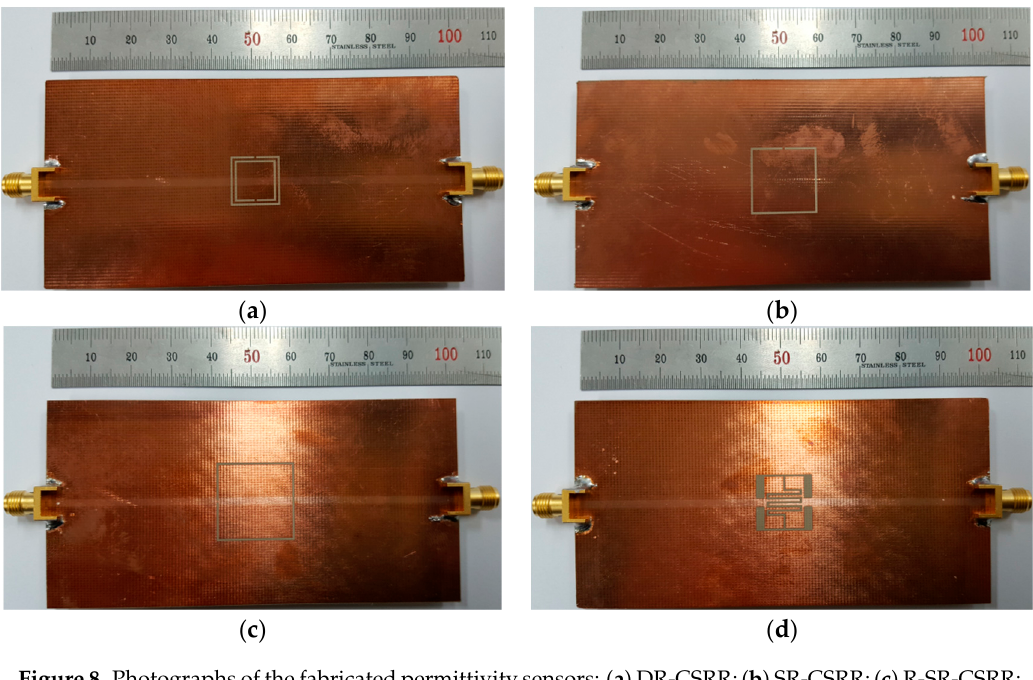
Figure 8. Photographs of the fabricated permittivity sensors: ( a ) DR-CSRR; ( b ) SR-CSRR; ( c ) R-SR-CSRR; ( d ) proposed IDCS-DGS. Sensors 2019 , 19 , 498